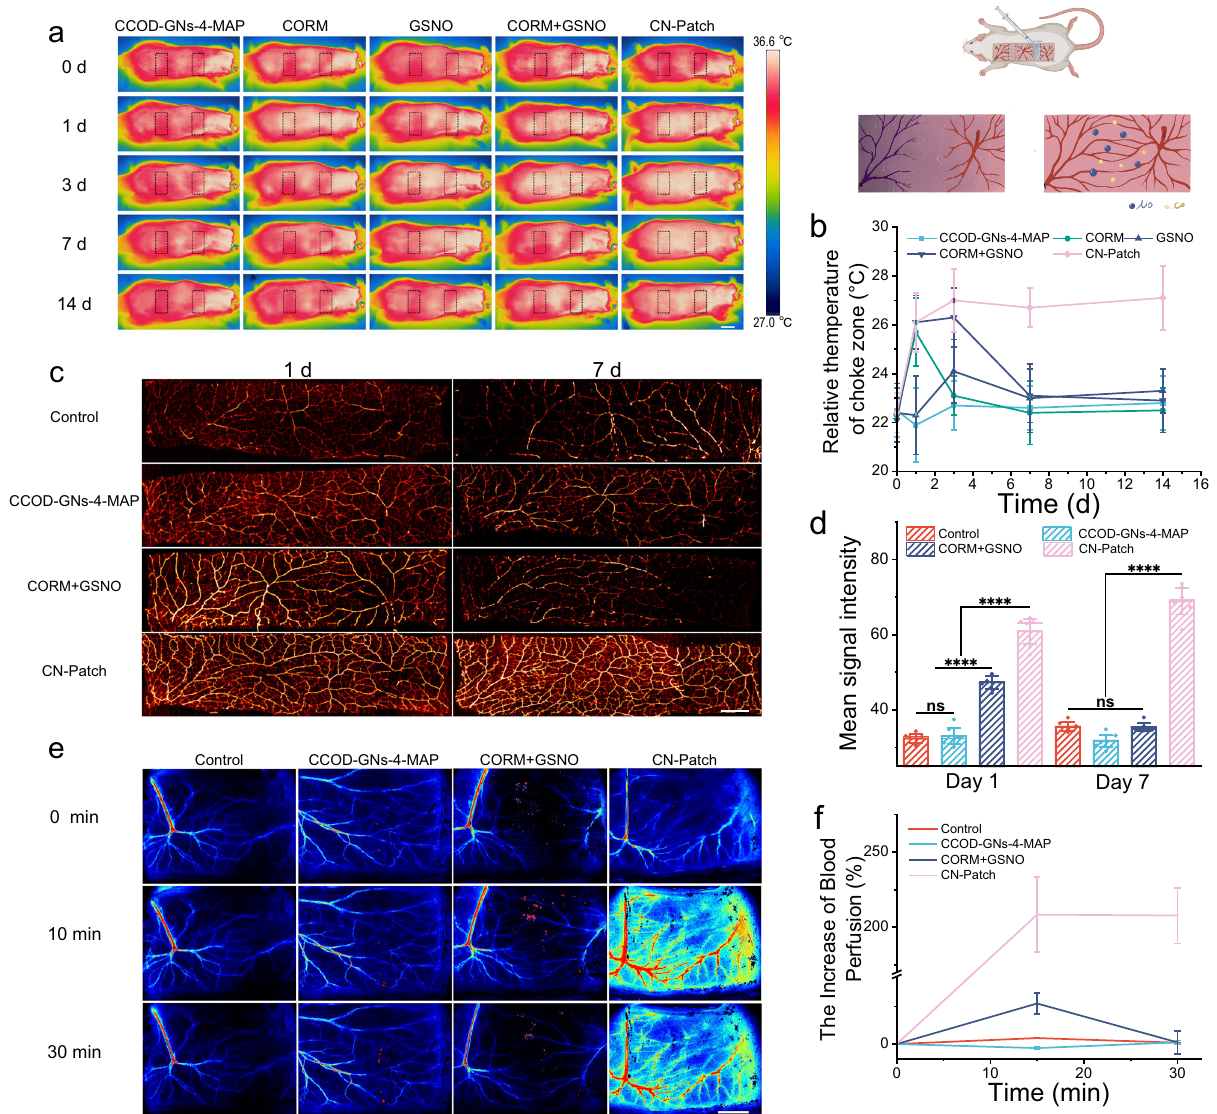
Fig. 3 | The vasodilating effect of CN-Patch. a , b The black rectangles indicated chokezones. The thoracic dorsal artery-posterior intercostal artery choke vascular areaandtheposteriorintercostalartery-deepiliaccircum fl exarterychokevascular area were the key monitoring areas, and an infrared thermal imaging camera was usedtotrackthelocaltemperatureaftertheintervention(days0 – 14)(mean±SEM, n =3independentanimalspergroup).Scalebar:1cm.Thetoprightillustrationwas designed using BioRender graphic tool (BioRender.com). c The postmortem arteriography of fl aps on day 1 and day 7 after administration. Scale bar: 1cm.